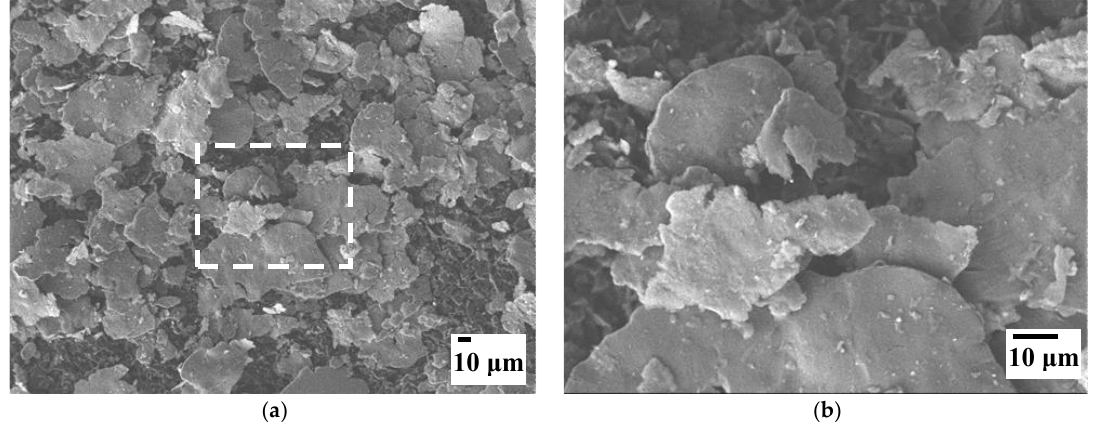
Figure 4. FESEM images of the AA7075 powder. ( b ) is a magnification from the boxed area in ( a ). For the composite powders, the EAFD particles are homogeneously dispersed at the surface of the AA7075 flakes (Figure 5). No micrometric EAFD agglomerates are observed. Figure 5a and Figure 5b show, respectively, the appearance of the starting powders 15G1 and 05G2 at low magnification. Figures 5c,d show higher magnification of selected areas in Figure 5a and Figure 5b, respectively. It can be seen that these powders are very similar, differing only in the surface area covered by EAFD on the AA7075 flakes.